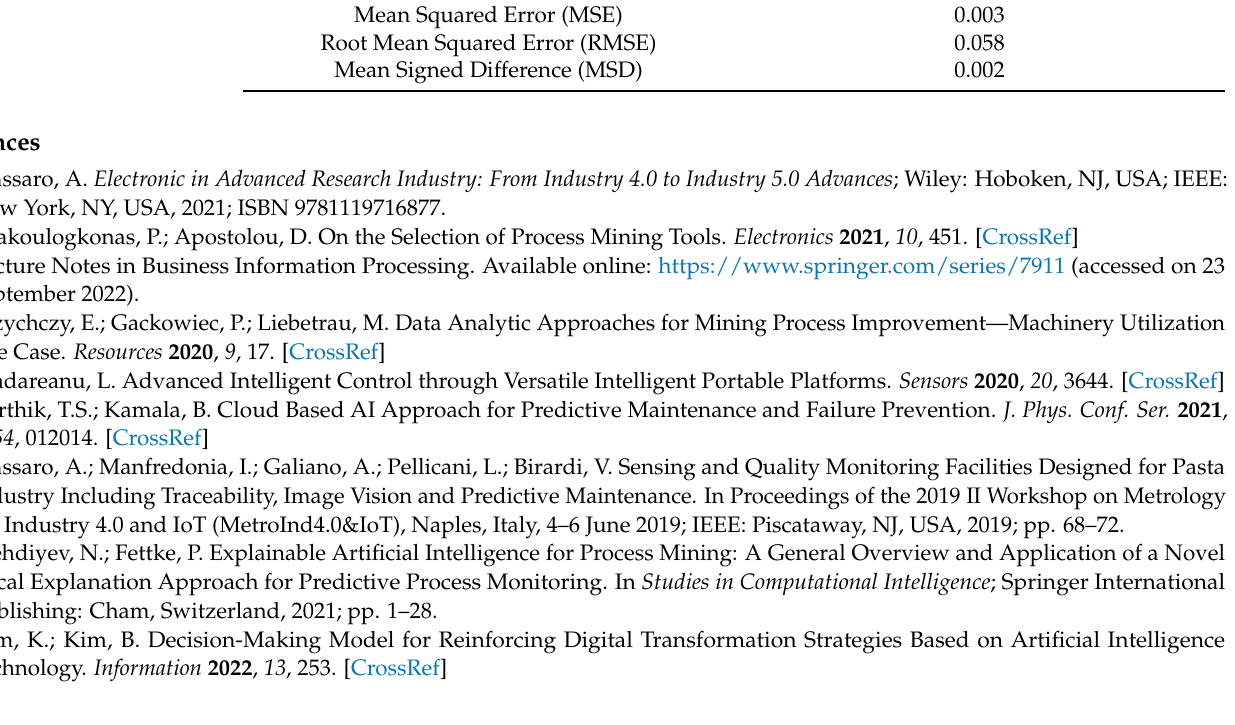
Table A1. Parameters of ANN-MLP performance.